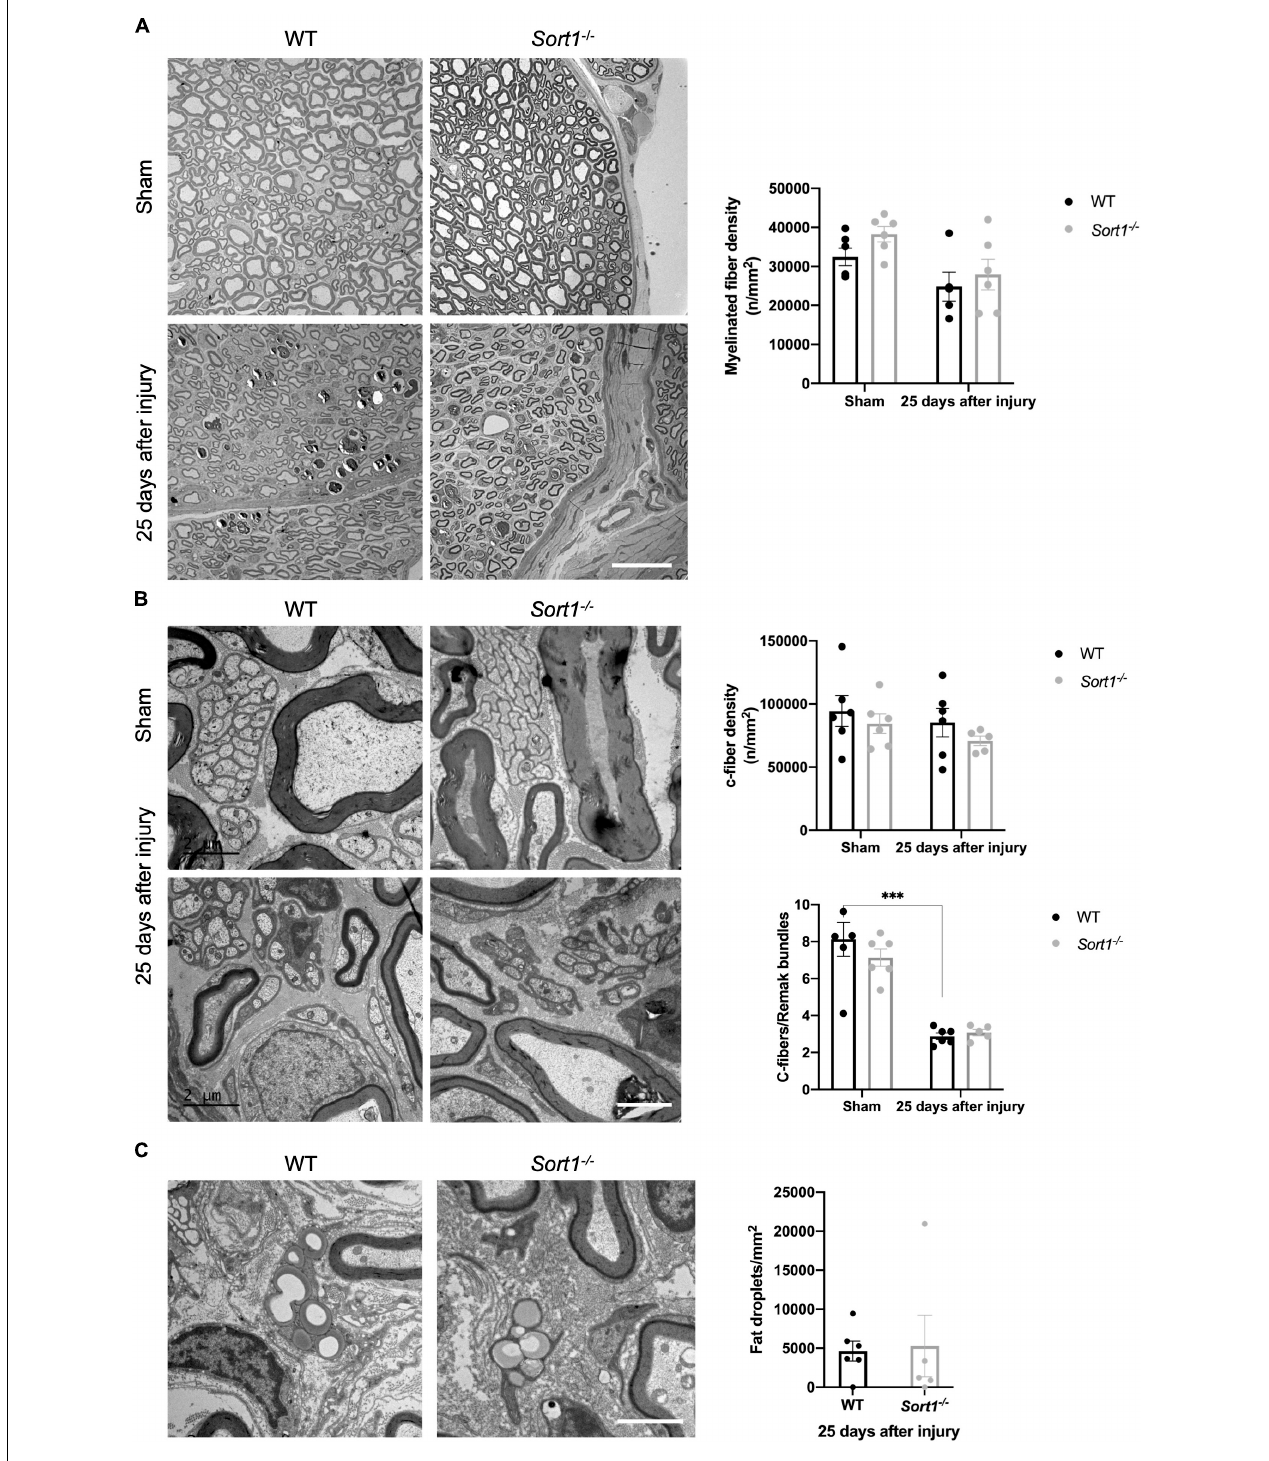
FIGURE 2 | Morphological and morphometrical analysis of crush-injured Sort1 − / − sciatic nerve. (A) Myelinated and (B) C-fiber densities were similar between Sort1 − / − mice and WT mice in the contralateral (sham) and 25 days after sciatic nerve crush injury. Representative EM images of thin transverse sections of sham contralateral or the distal stumps of crush-injured sciatic nerves 25 days after injury [scale bar (A) : 20 µ m; (B) : 2 µ m]. Bottom graph in panel (B) shows the average number of C-fibers/Remak bundle, which were significantly lower (*** p < 0.001) in both crush-injured WT and Sort1 − / − sciatic nerve compared to the contralateral sham control. (C) Representative images of fat droplets in thin transverse sections of injured WT or Sort1 − / − sciatic nerve 25 days after sciatic nerve crush injury. The total number of fat droplets/mm 2 were similar between WT and Sort1 − / − .